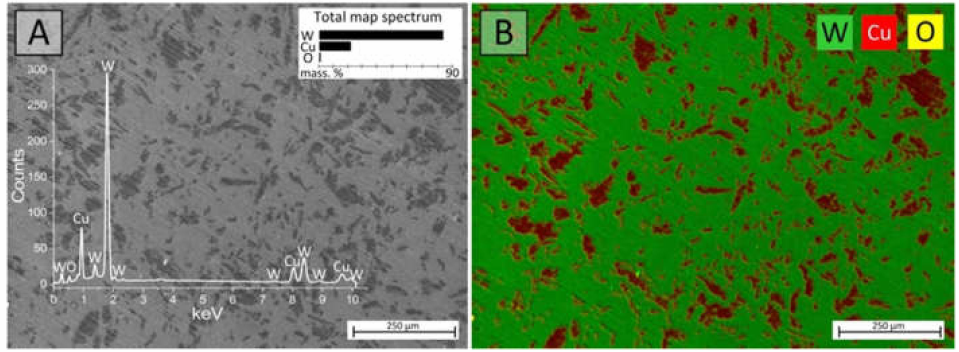
Figure 4. SEM image ( A ) and EDX map ( B ) of the W–Cu composite